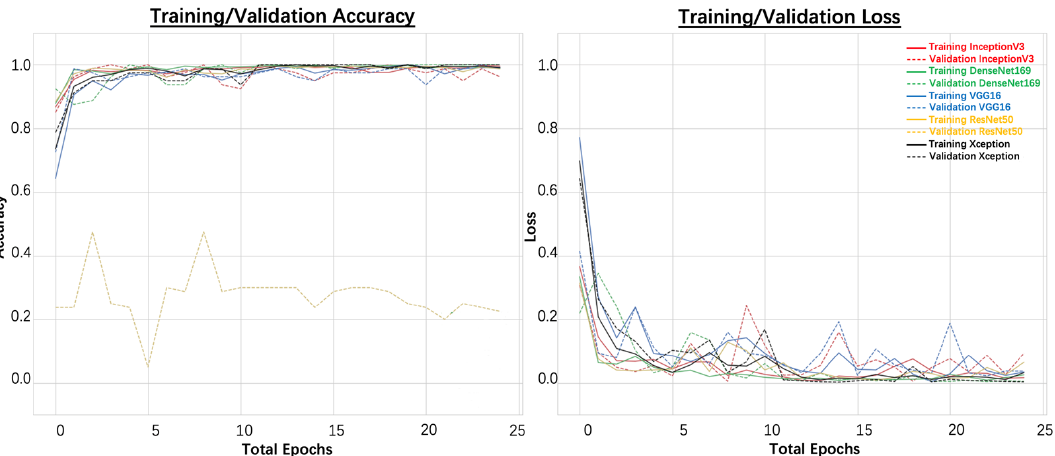
Figure 5. Training and validation accuracy and loss plots for training deep learning models to identify diseased regions using tile segments of size 500 × 500 pixels.